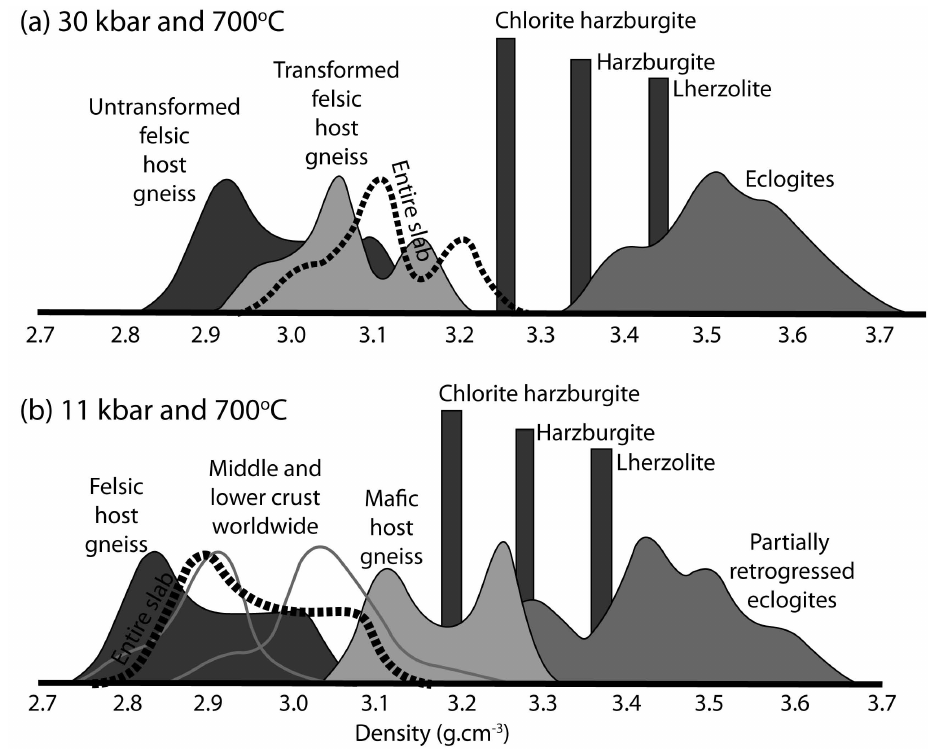
Fig. 4. Figure modified from Walsh and Hacker (2004) showing the calculated densities of the WGR at (a) UHP conditions and (b) during the amphibolite-facies overprint, using the formalism of Hacker and Abers (2004). Mafic rocks were estimated to form 10% by volume of the subducted